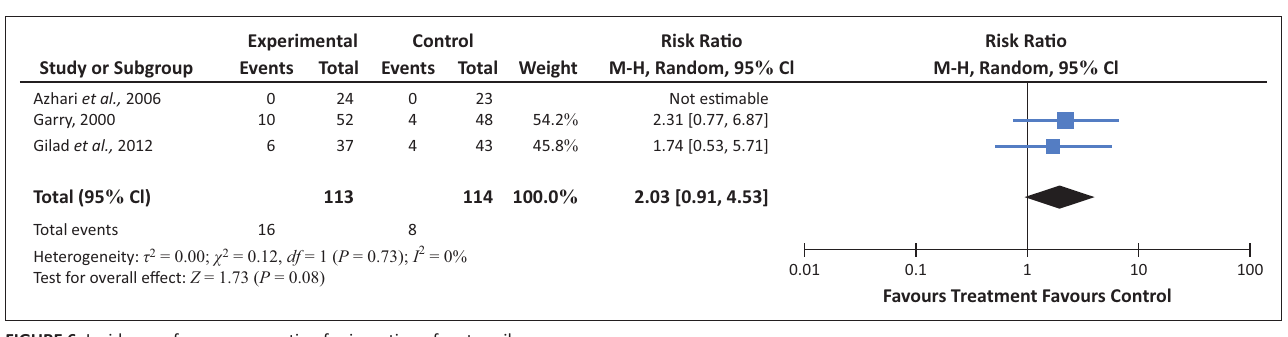
FIGURE 6: Incidence of caesarean section for ingestion of castor oil.